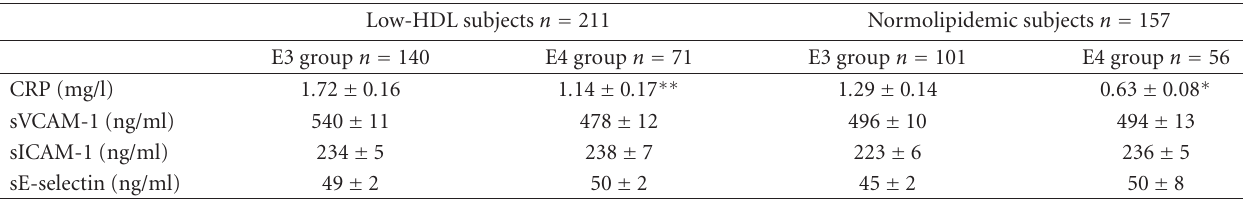
Table 2: The concentrations of hsCRP, sVCAM-1, sICAM-1, and sE-SELECTIN in Low-HDL subjects and normolipidemic subjects divided by apoE subgroups.